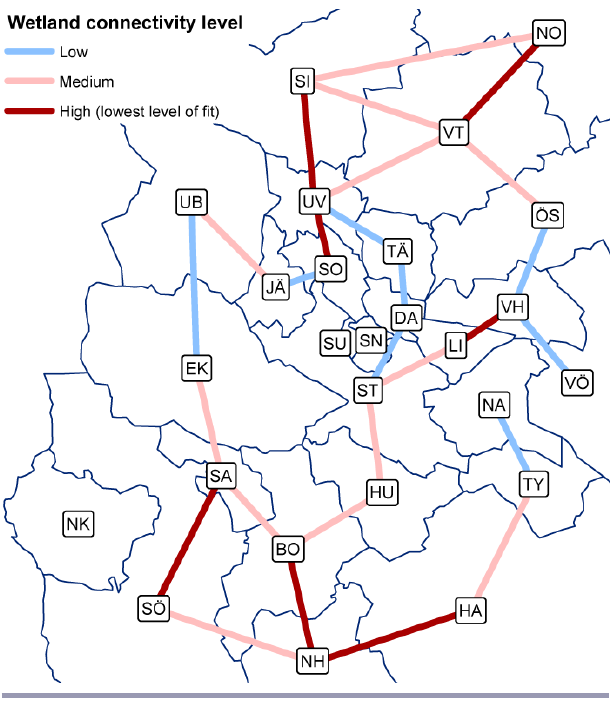
Fig. 7 . A link represents wetland connectivity not matched by collaboration (that is, a link means that collaboration is absent). Link color represents the level of mismatch interpreted as the urgency of establishing a new collaboration to protect the corresponding level of wetland connectivity. The names of the municipalities are abbreviated as follows: BO = Botkyrka, DA = Danderyd, EK = Ekerö, HA = Haninge, HU = Huddinge, JÄ = Järfälla, LI = Lidingö, NA = Nacka, NO = Norrtälje, NK = Nykvarn, NH = Nynäshamn, SA = Salem, SI = Sigtuna, SO = Sollentuna, SN = Solna, ST = Stockholm, SU = Sundbyberg, SÖ = Södertälje, TY = Tyresö, TÄ = Täby, UV = Upplands Väsby, UB = Upplands-Bro, VT = Vallentuna, VH = Vaxholm, VÖ = Värmdö, ÖS =